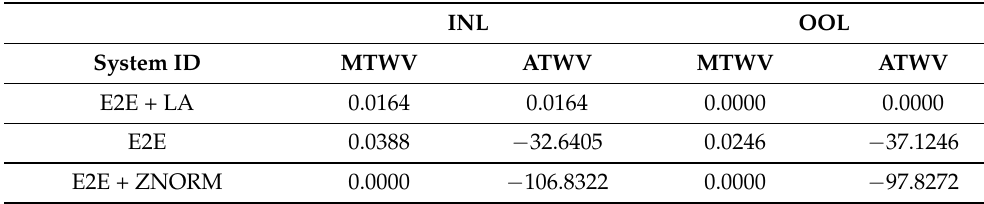
Table 28. System results of the QbE STD task for SPARL20 test data for in-vocabulary (INV) and out-of-vocabulary (OOV) queries.